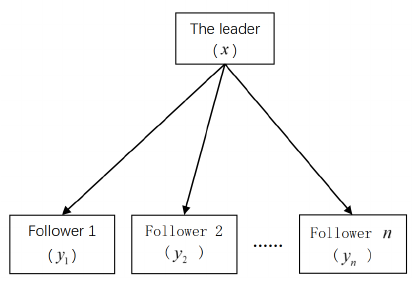
Figure 1. The model of the single-leader–multi-follower